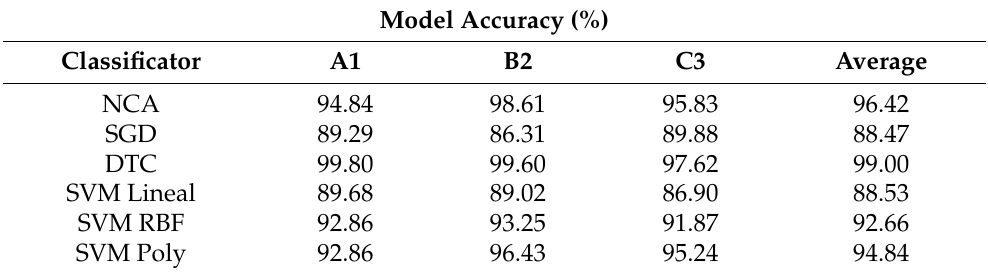
Table 4. Model accuracy comparison of multiple classifiers.